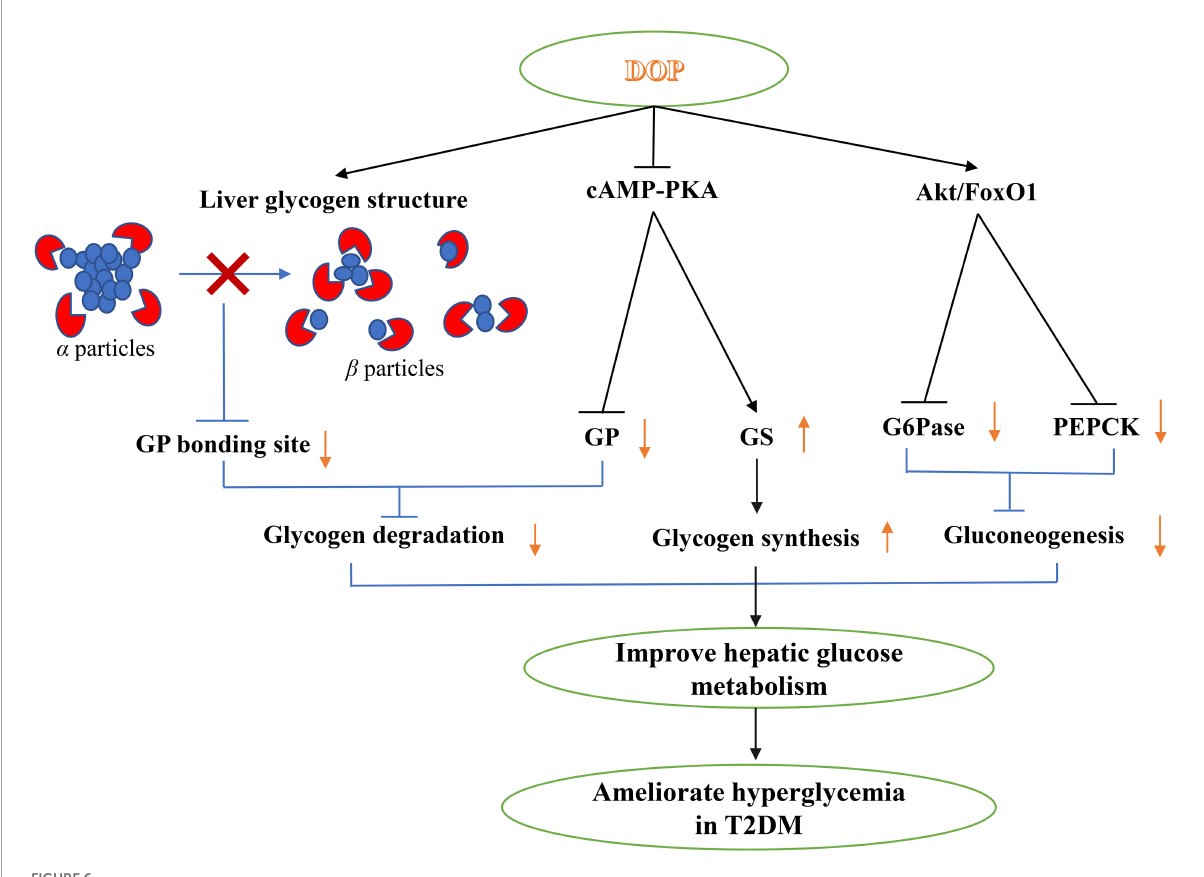
FIGURE6 The potential hypoglycemic mechanisms of D. officinale